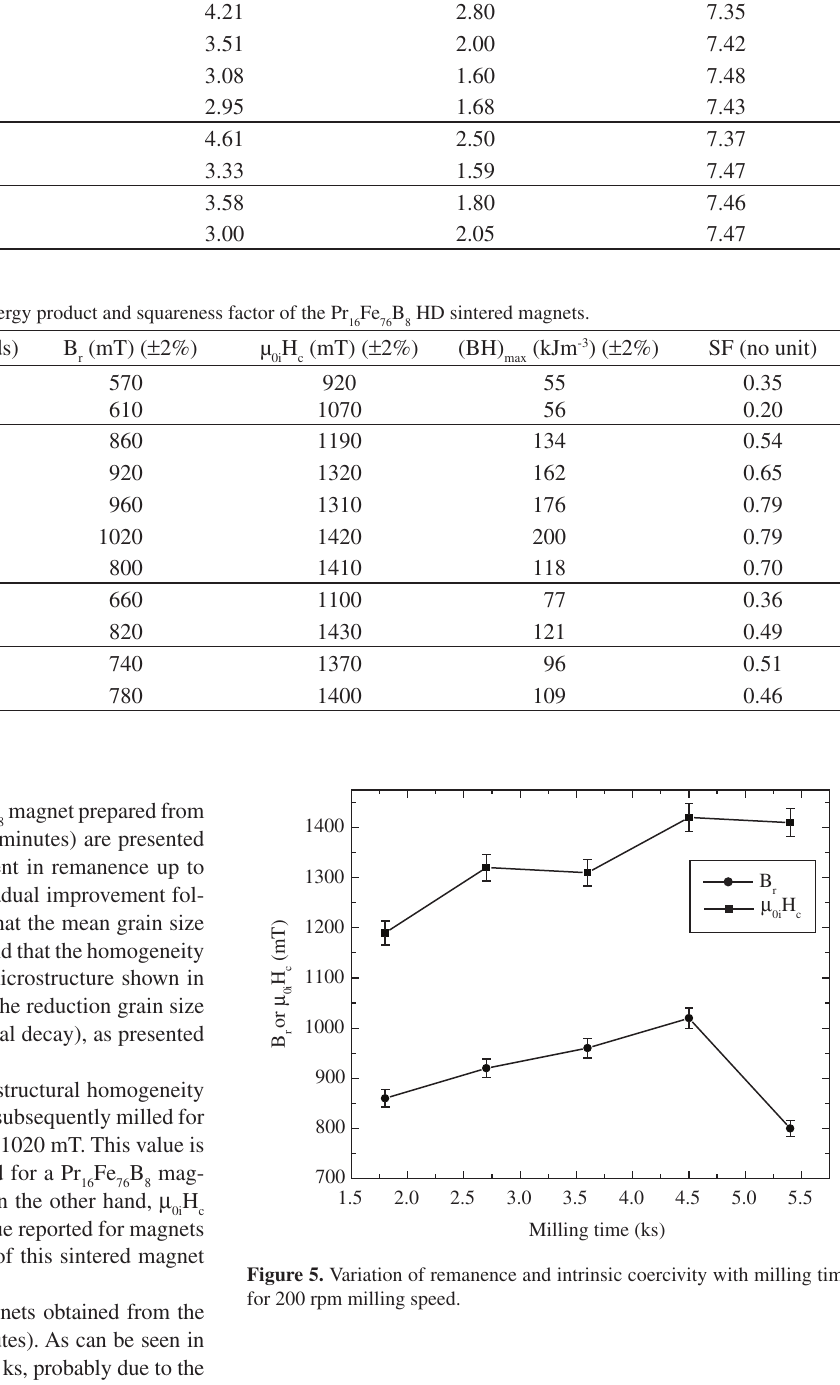
Fe B HD sintered magnets. 16 76 8